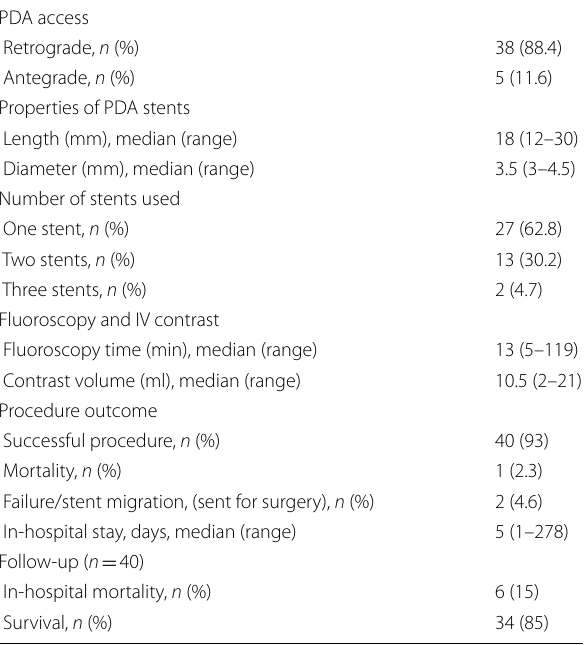
PDA patent ductus arteriosus, IV intravenous